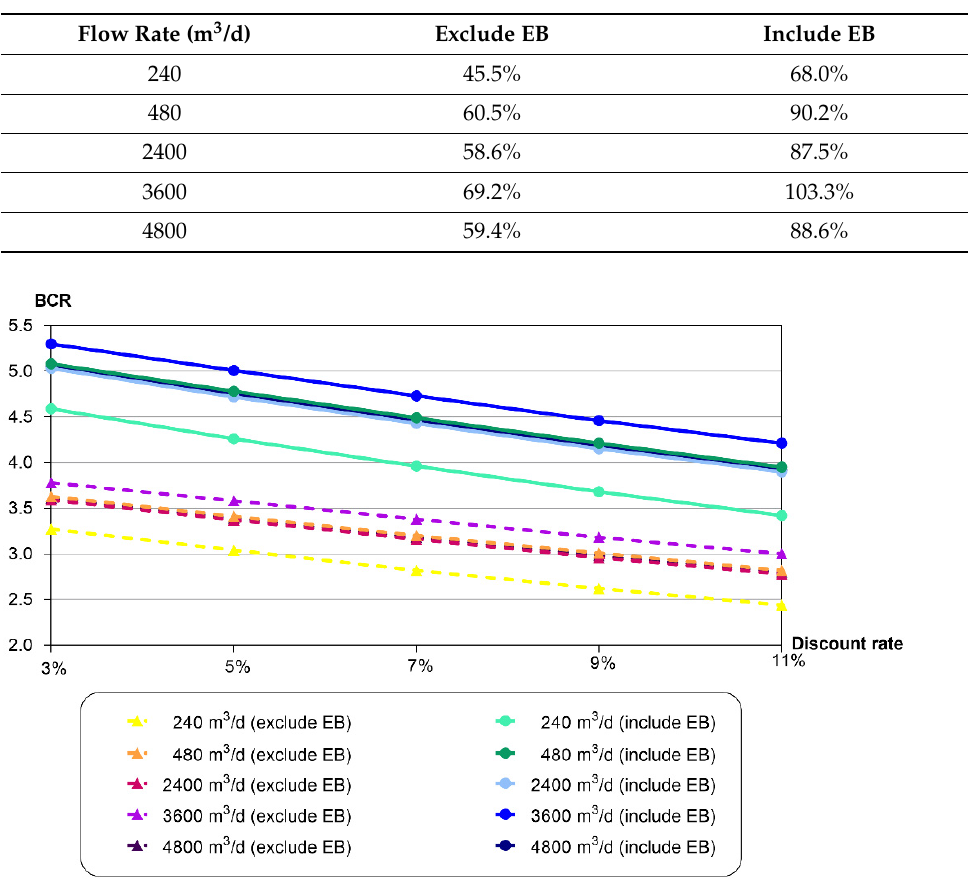
Figure 7. Benefit–cost ratios (BCRs) for water reclamation projects for the irrigation of plants and green areas when including and excluding environmental benefits (EB) . green areas when including and excluding environmental benefits